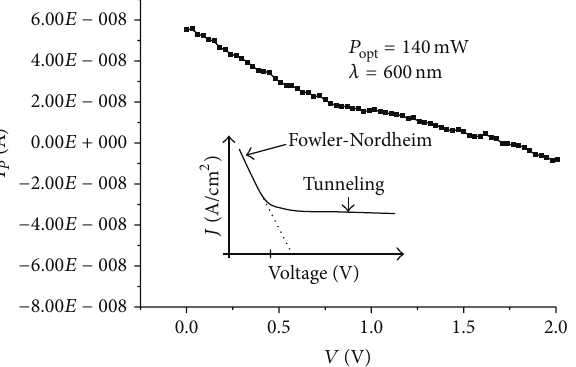
Figure 11: Photogenerated current characteristics of a 3D array under illumination pulse with 𝜆 = 600 nm at room